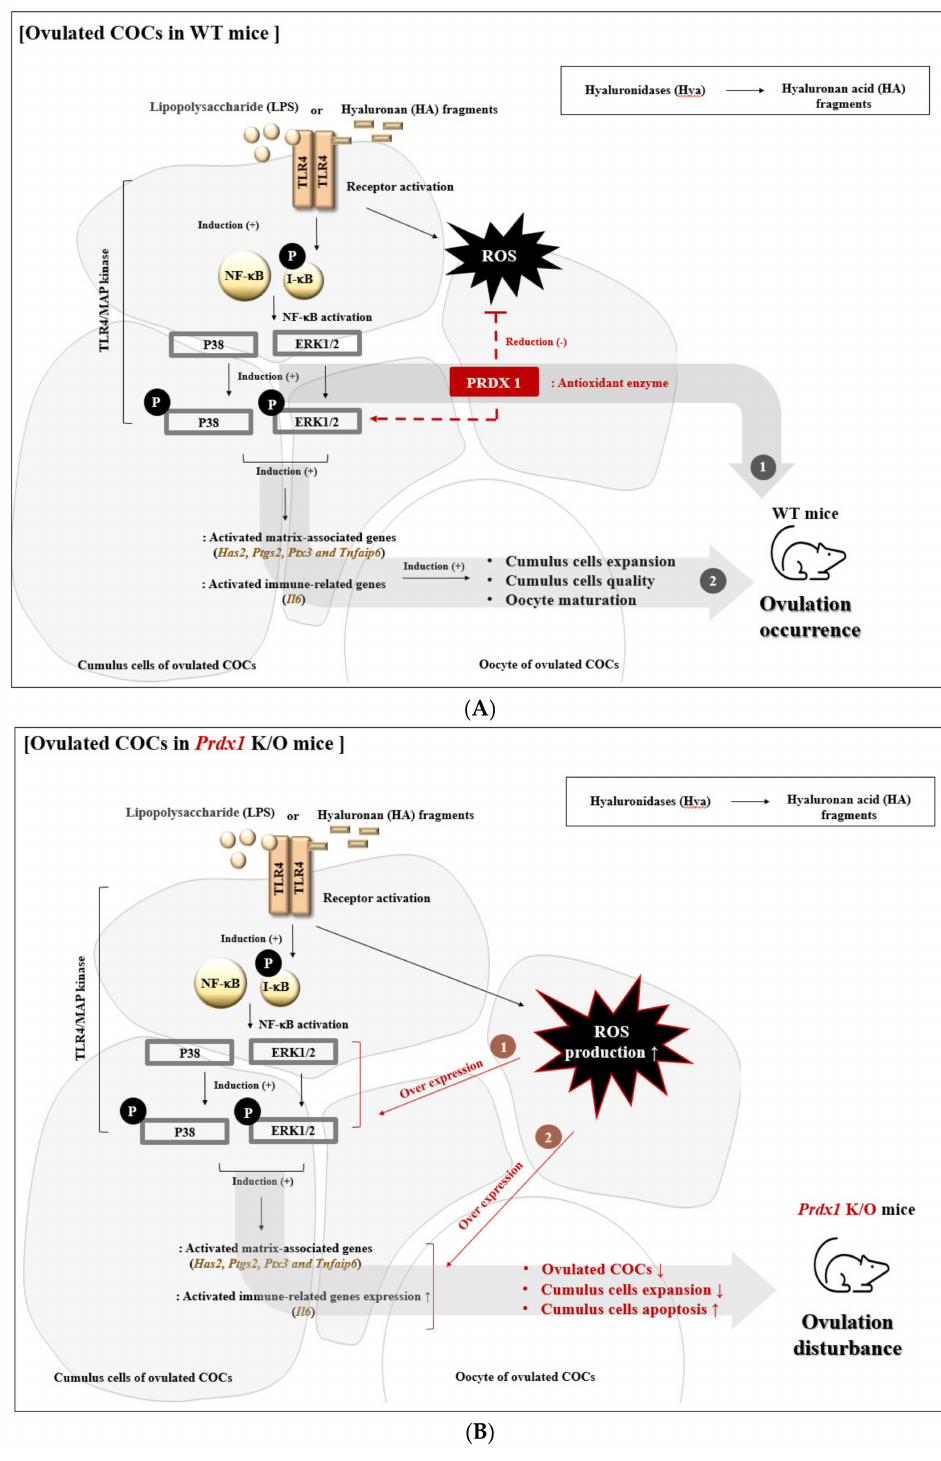
Figure 7. ( A ) WT mice: Roles of PRDX1 in cytokine secretion function and the ovulatory process associated with the TLR4-derived ERK1/2 MAP kinase activity in the ovulated COCs of mice, showing the effect of PRDX1 on the secretory functions ( Tnfaip6, Il-6 , and Ptgs2) of cumulus cells, leading to ovulation by activation of TLR4-mediated ERK signaling in ovulated COCs. ( B ) Prdx1 K/O mice: In the present study, these observations demonstrated novel evidence of the effects of Prdx1 , as a directly upregulated response to ERK1/2 signaling for regulating ROS production, on the secretory functions of cumulus cells by TLR4 pathways in ovulated COCs from Prdx1 K/O